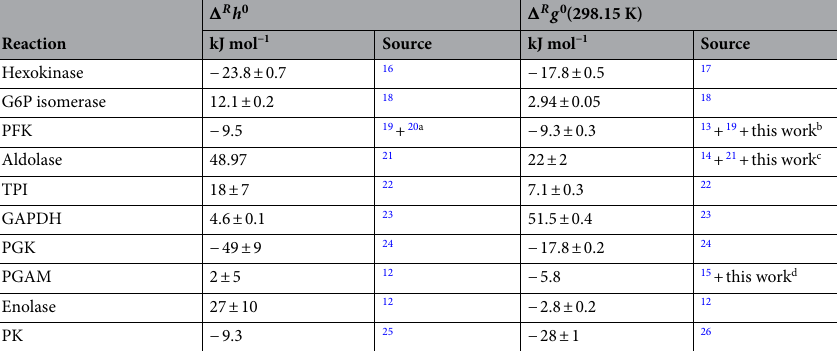
0 Table 1. Standard enthalpy of reaction of glycolysis (cid:31) R h and standard Gibbs energy of reaction of glycolysis (cid:31) R g 0 at pH 7 with the respective sources. a Value originally from Redman–Furey 19 ; according to Goldberg et al. 20 calorimetrically determined enthalpies (using different buffers at pH 9.0 and 298.15 K) were used to R h 0 calculate (cid:31) = 9.5 kJ mol −1 with the change in the binding of H + and enthalpies of ionization of the buffers. b–d See text for more detail.